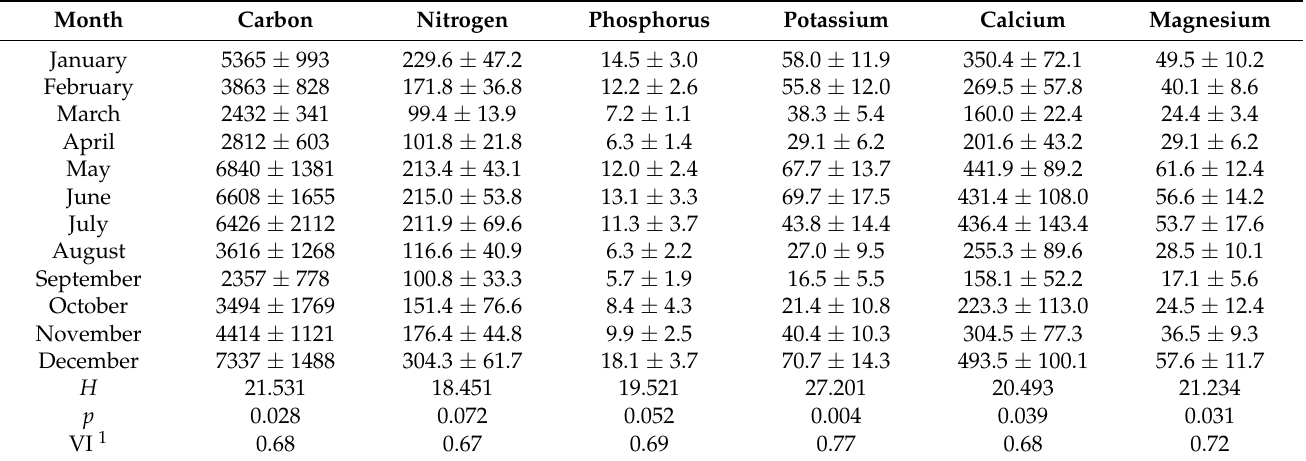
1 Variability Index = (monthly maximum − monthly minimum)/monthly maximum. The micronutrients contained within the leaf litterfall were also contrasting among the months (Table 2). The leaf Zn content did not differ among the various months and averaged 197 µ g · m − 2 . The Mn content of leaf litter was least in March and most